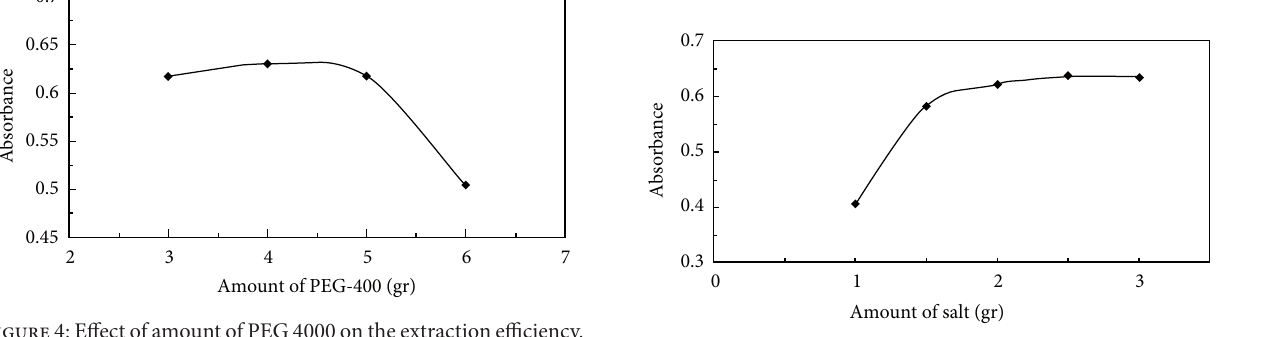
F 6: Effect of amount of salt on the extraction efficiency. Experimental conditions: volume of buffer; 9mL, pH of sample; 5.5, C,centrifuging amount of PEG 4000; 4gr, temperature; 35 ∘ 10min, 4ng/mL of brilliant